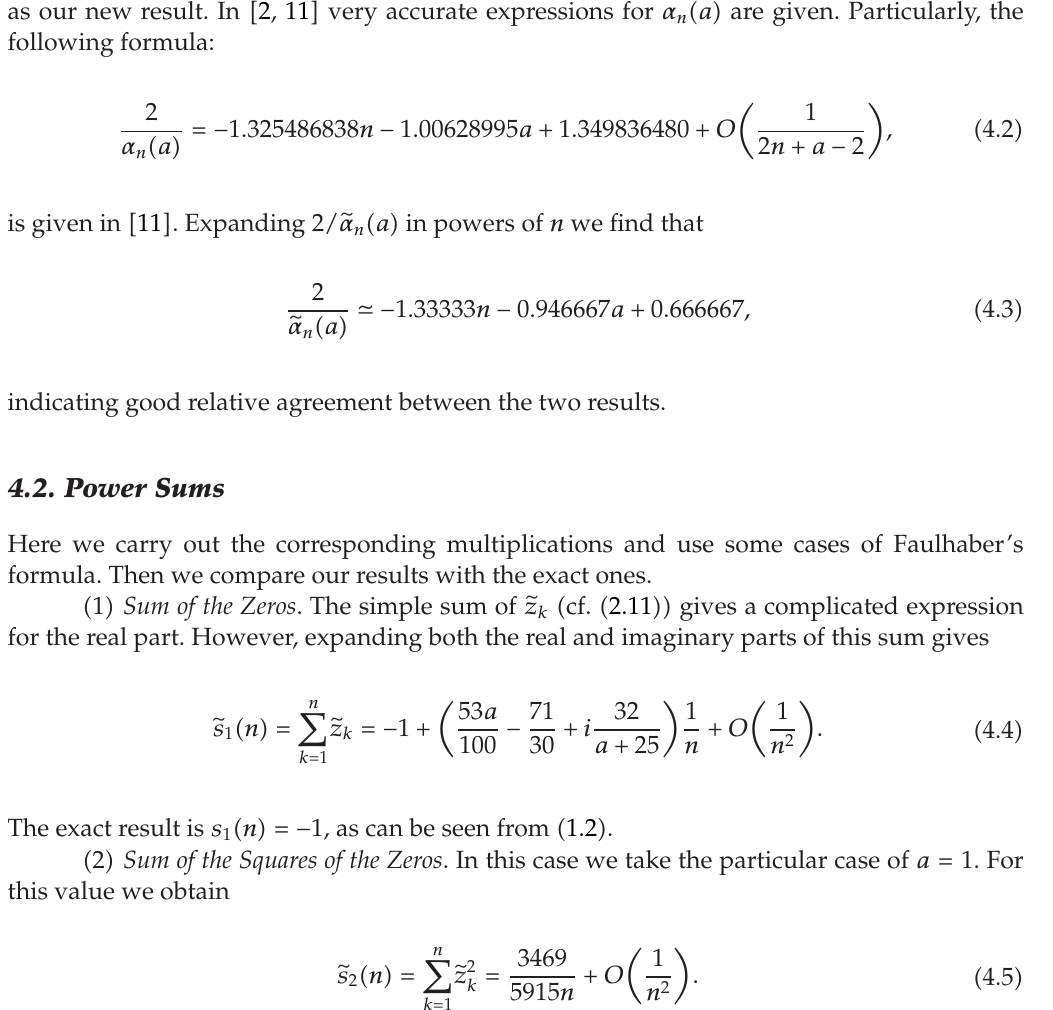
Figure 4: Plot of the values of max n k (cid:4)